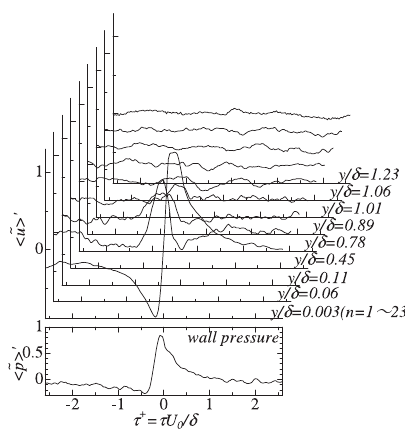
Fig. 14 Ensemble-averaged time histories of conditionally sampled velocity and wall static pressure at higher modes ( n = 4 ∼ 23). The detection is based on the VITA technique applied to the original flow field ( n = 1 ∼ 23) at y/δ =